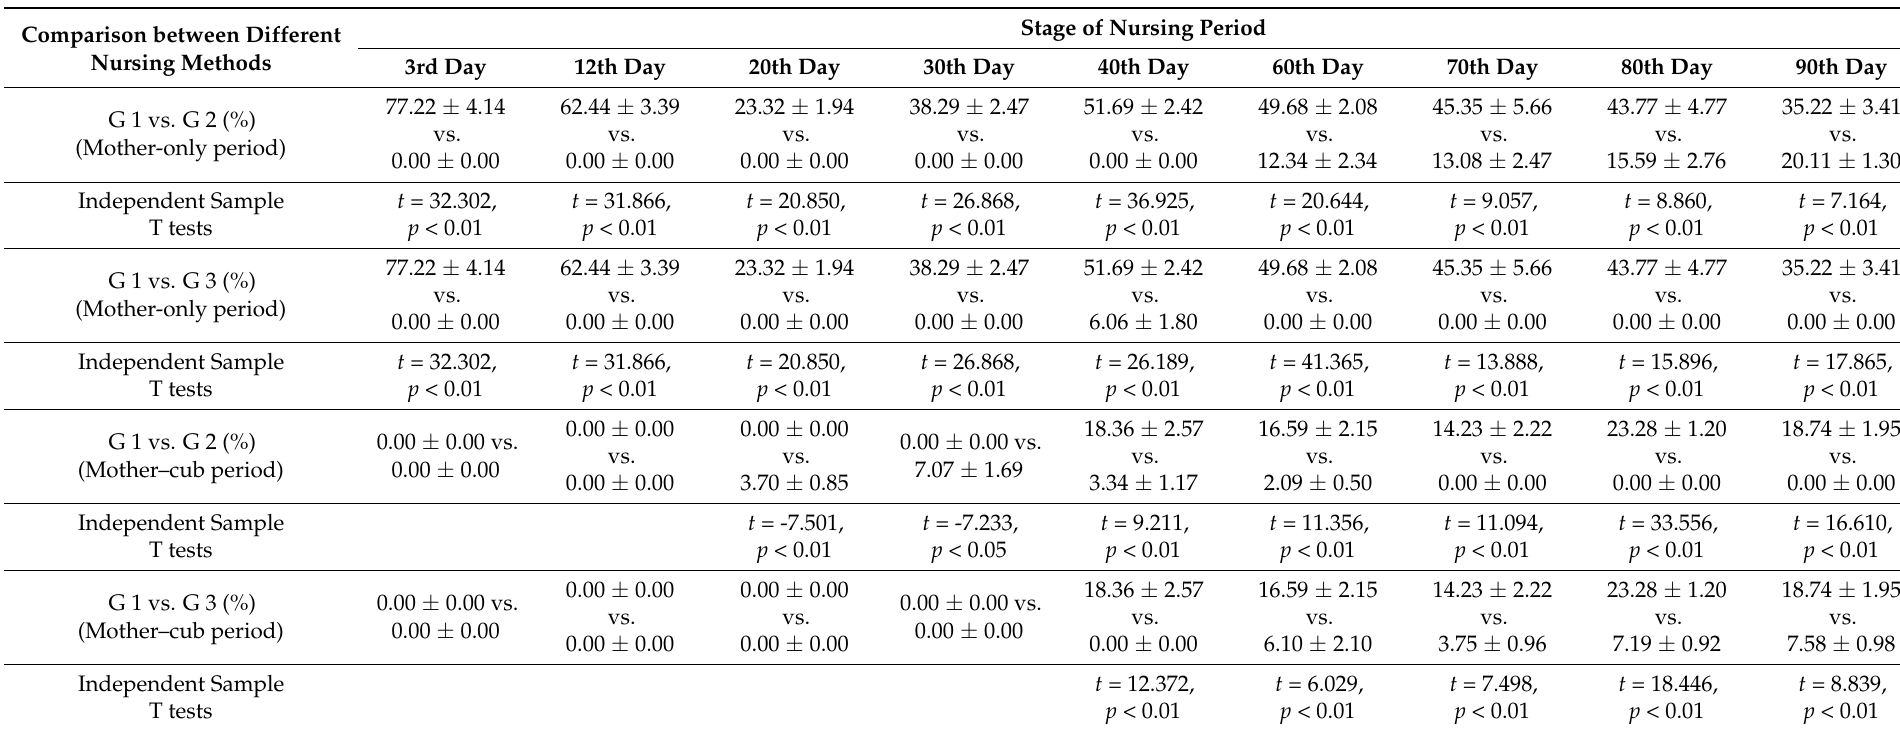
Table 4. Comparison of resting behavioral responses of different nursing group panda mothers during the different stages of